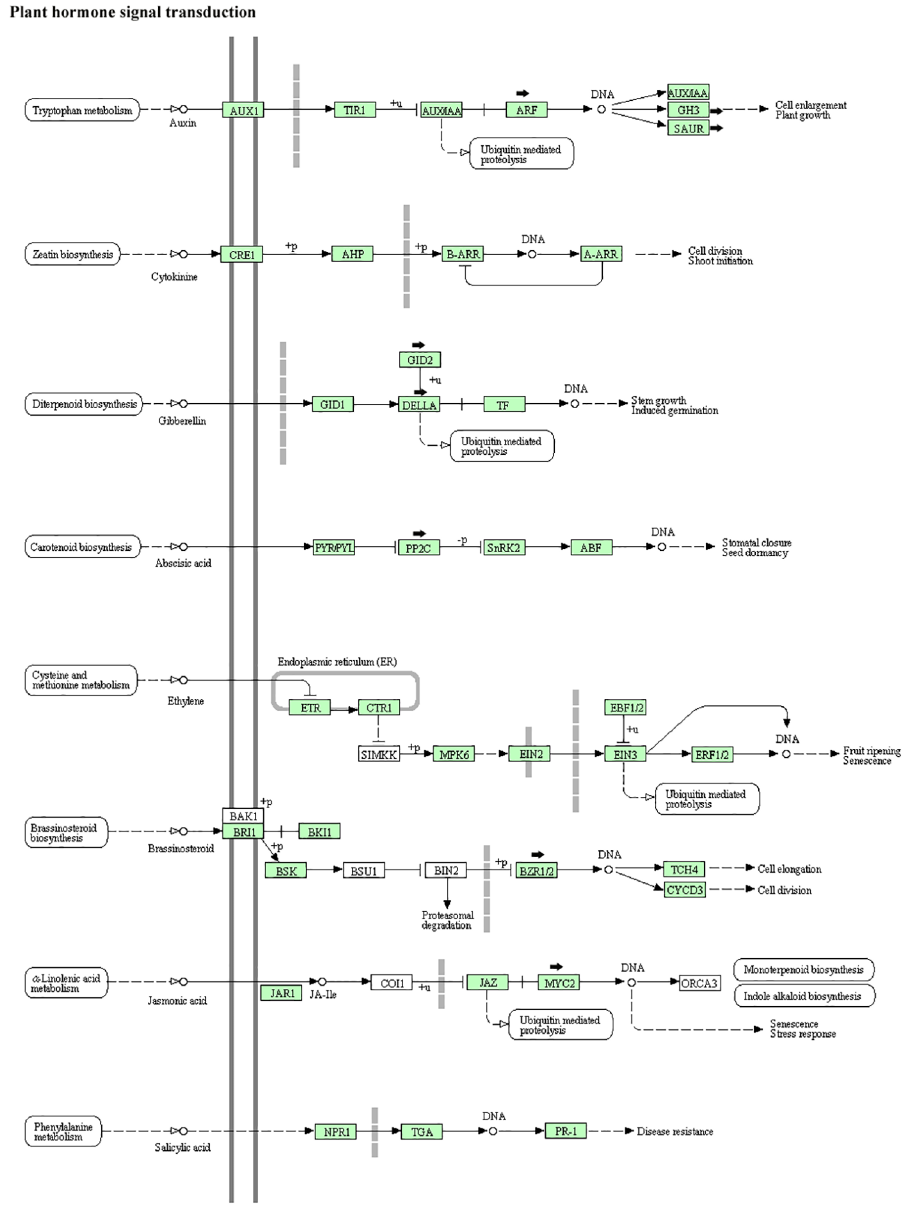
Fig 3. Plant hormone signal transduction. Thirty-seven unigeneswere assignedto plant hormonesignal transduction pathways by KEGG. The kiwifruit unigenesinvolvedin these pathways are marked in green. Arrows indicate differentially expressedgenes closely associated with hormonesynthesis and